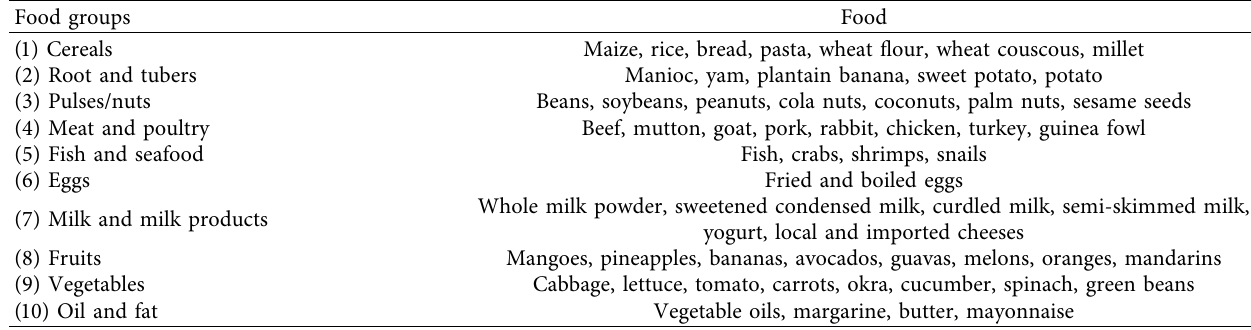
Table 1: Group of food used for the DDS.